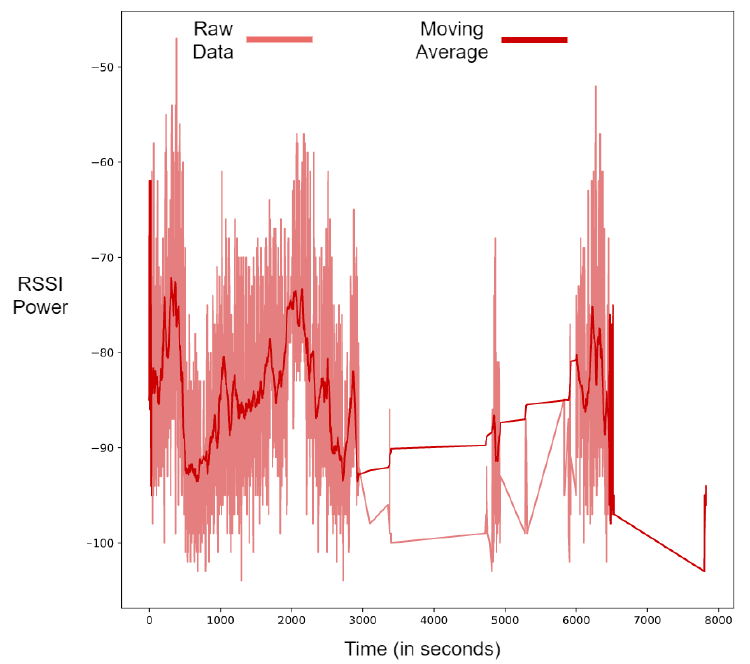
Figure 3. Impact of moving average method on raw data collected by one